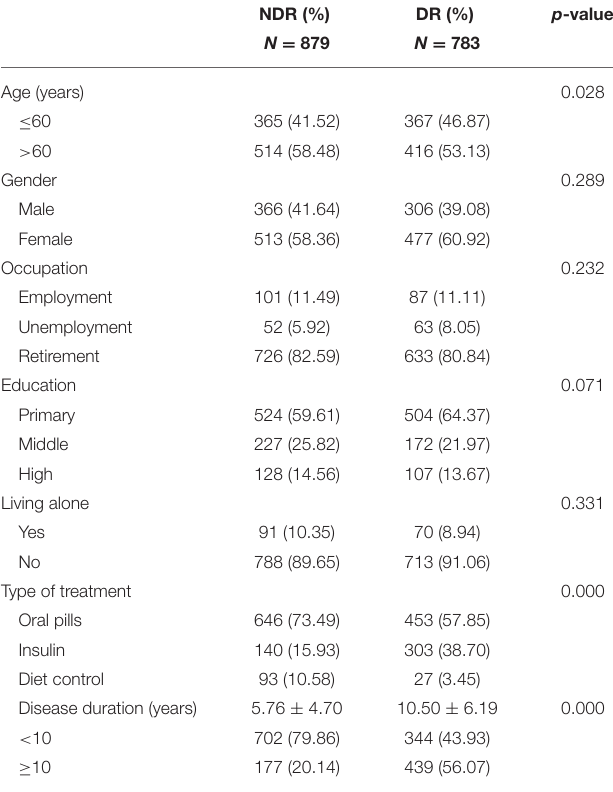
TABLE 1 | The demographic characteristics of NDR and